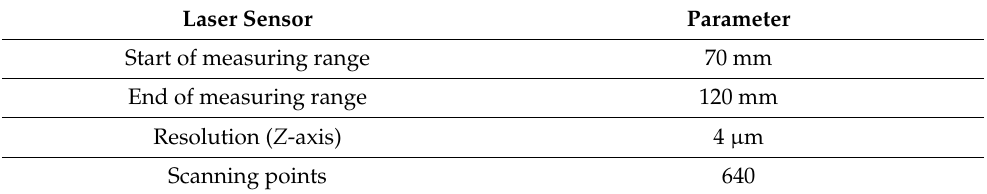
Figure 2. The experimental inspection laboratory stand; first step ( left ): scanning the shaft as a calibration process; second step ( right ): scanning the gear wheel. Table 1. Parameters of a laser